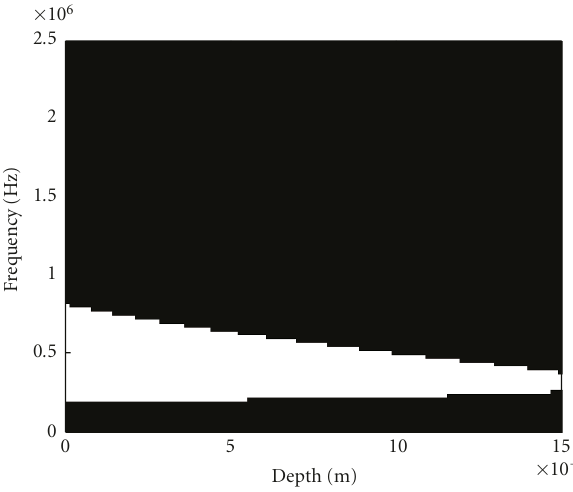
Figure 2: An example of a binarized TFR diagram with the mixed threshold. Simulation parameters of the ultrasonic pulse were central frequency f c = 500KHz, AWGN of variance 0.15, and D =